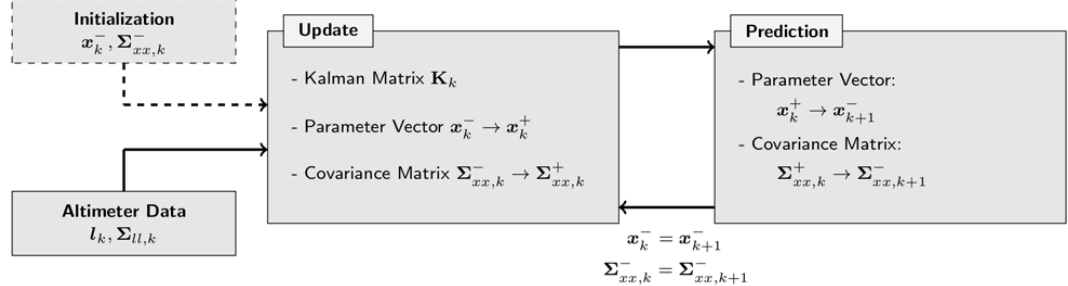
Figure 3. Procedure of Kalman filtering starting with an initialization step followed by a progressive loop containing one update and one prediction